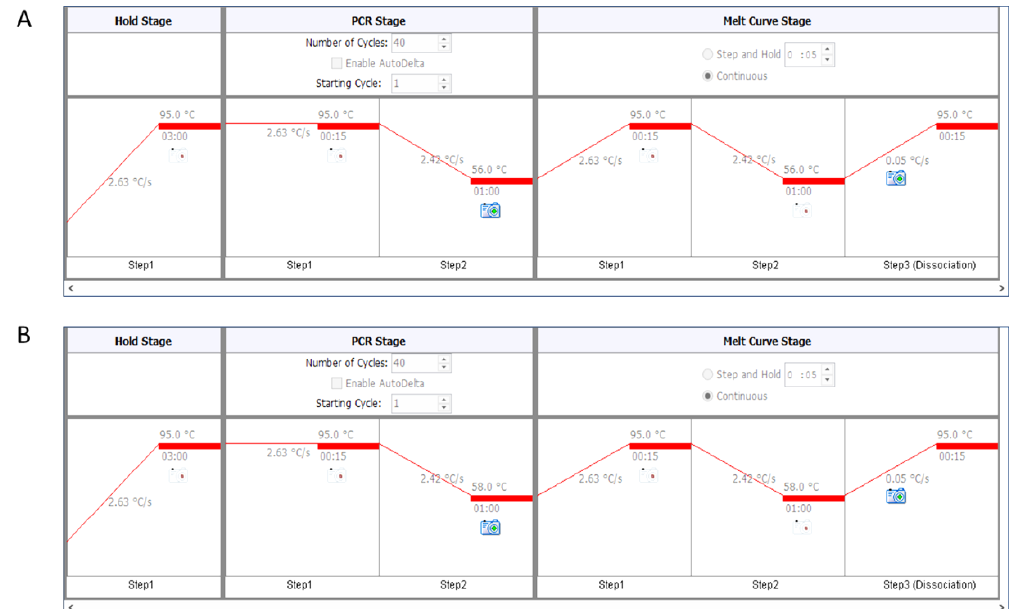
Figure 2. Details of the PCR setup. Detailed information of the PCR setup on the ViiA7 instrument with telomere primers ( A ; annealing at 56 °C) and human β-globin primers ( B ; annealing at 58 °C) is provided. Cycling temperatures with time, number of cycles, as well as ramping rates are clearly indicated here. A melt curve analysis is added at the end of 40 cycles of PCR to ensure the absence of primer-dimers.